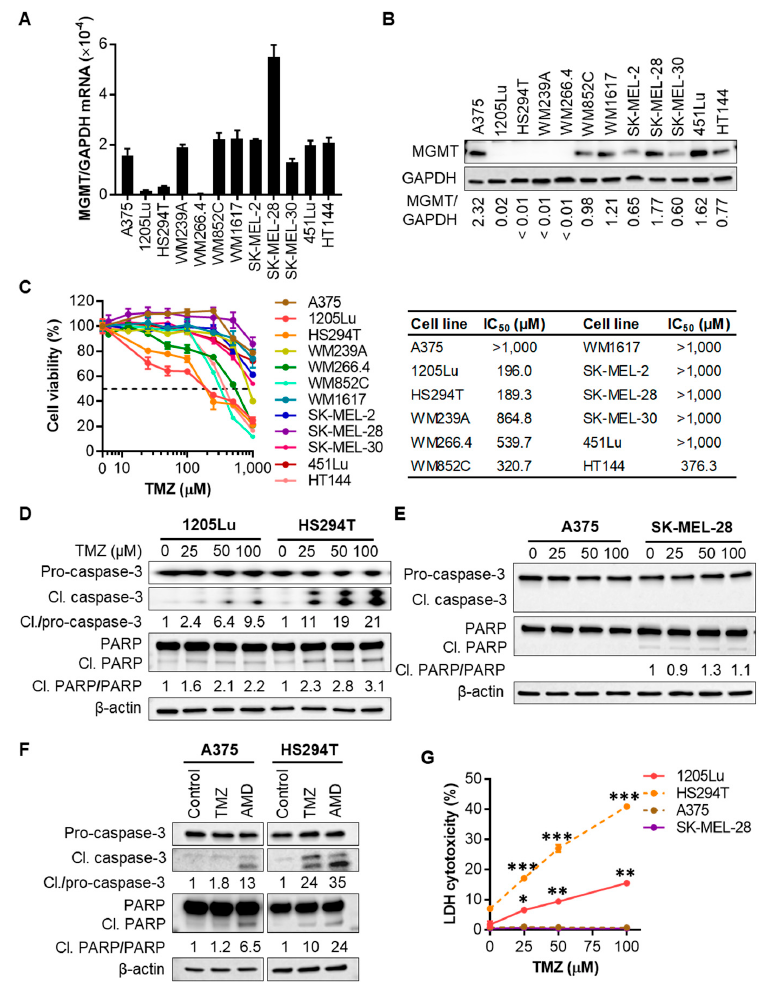
Figure 1. Melanoma cell lines with low expression levels of O 6 -methylguanine-DNA